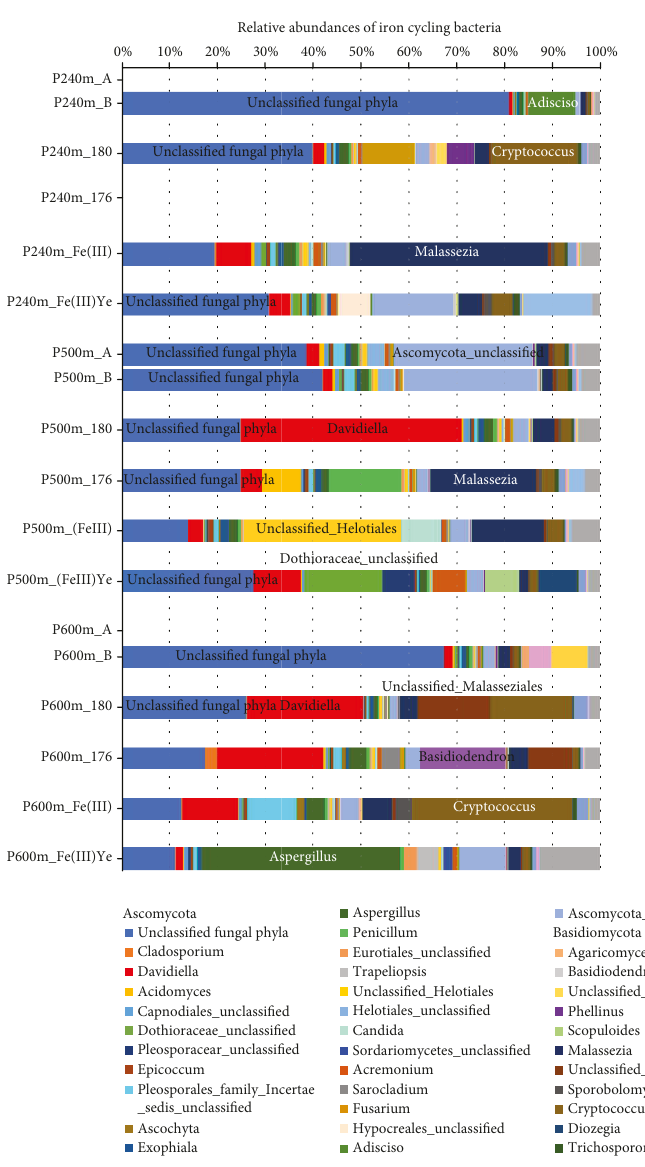
Figure 6: Relative abundance of fungal genera detected in the original water samples and the enrichment cultures. Fungal genera with relative abundances of less than 0.1% of the sequence reads are grouped into the category “ Other. ” The fungal phyla are indicated to the right of the legend and Cm stands for